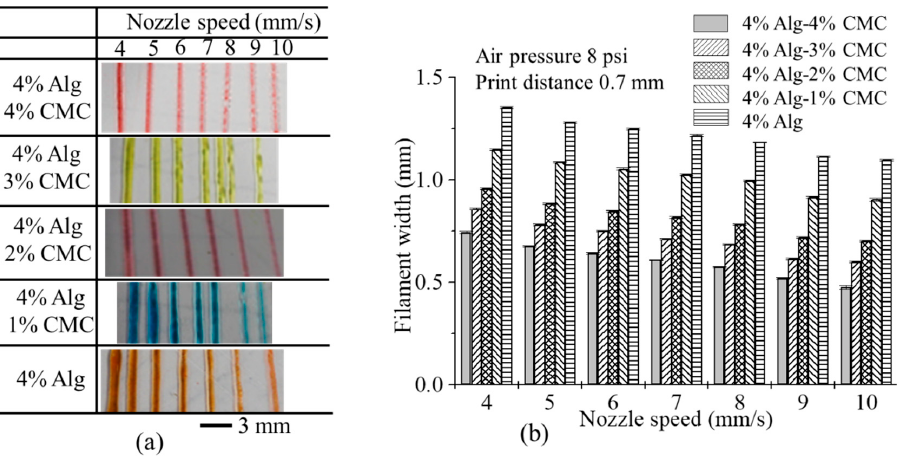
Figure 13. ( a ) Printed filaments at different nozzle speed; ( b ) the effect of nozzle speed on filament width.